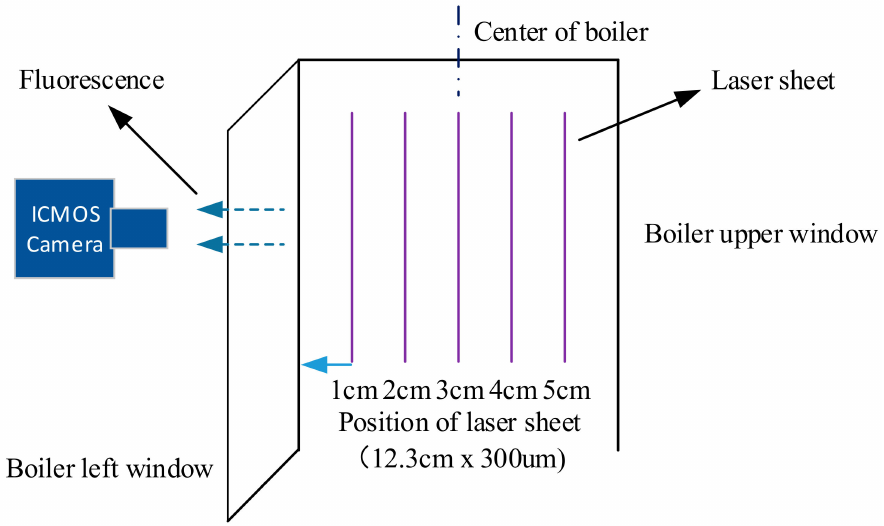
Figure 9. Schematic diagram of laser sheet position.